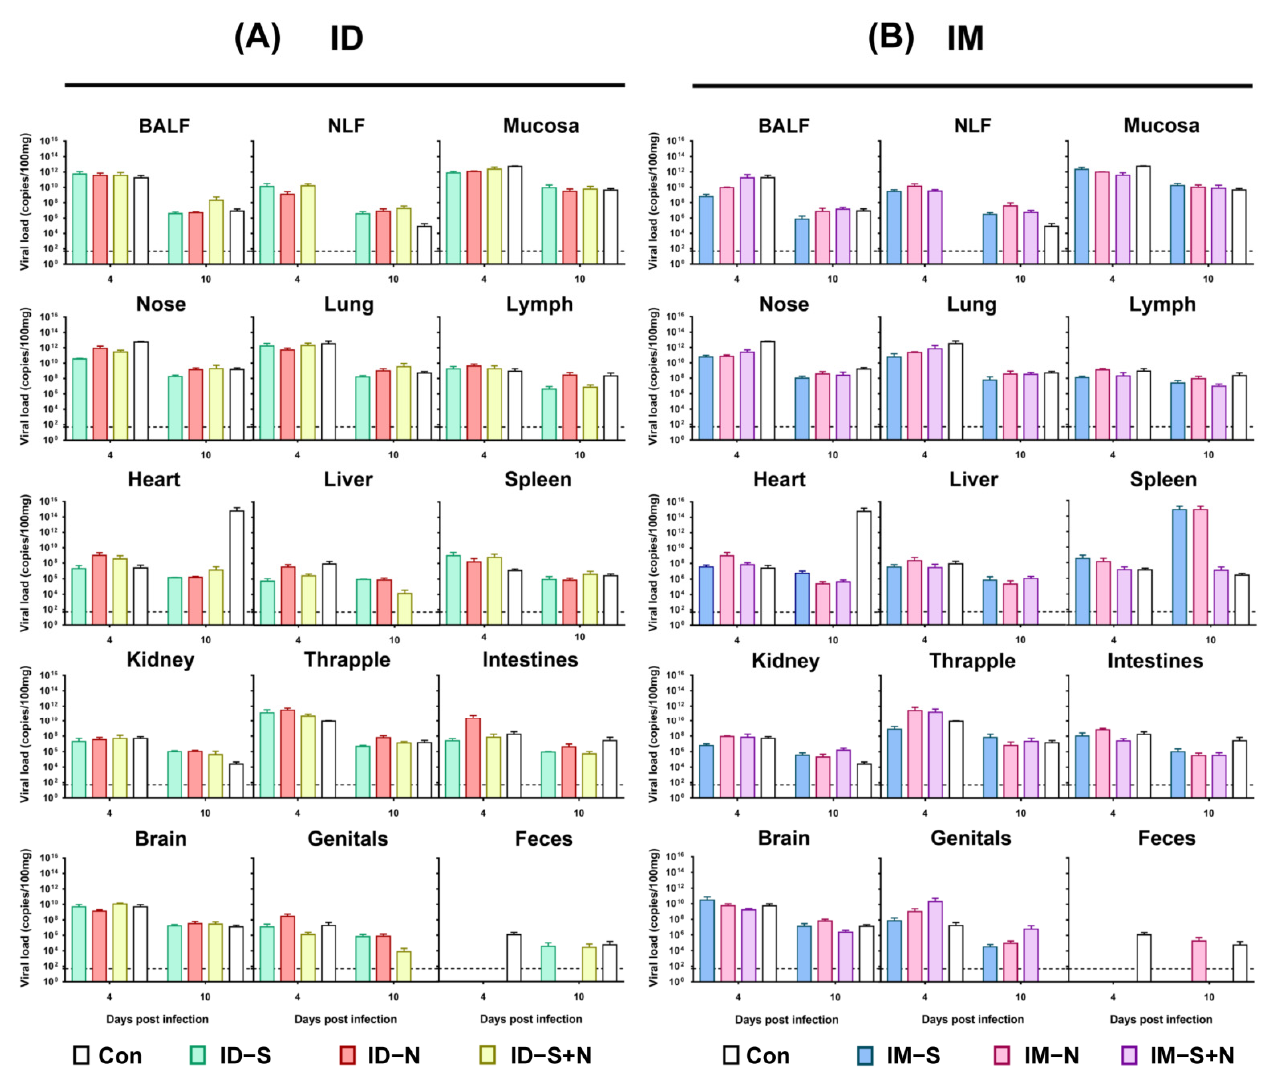
Figure 5. The viral loads in various tissues and organs of hamsters immunized with experimental recombinant proteins via the ID and IM routes after SARS-CoV-2 challenge. ( A ) Challenge after ID and ( B ) challenge after IM. RNA was extracted, and the viral load was determined as copies per 100 μ L. BALF: bronchoalveolar lavage fluid; NLF: nasal lavage fluid. The dotted line in the figure indicates the detection threshold of the PCR method of 50 copies/100 μ L ( n = 3 per group for each time point).